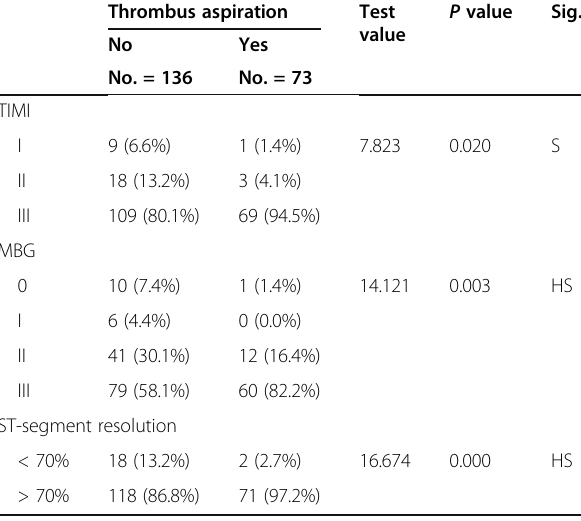
Table 5 Comparison between the 2 groups regarding TIMI flow, MBG, ST-segment